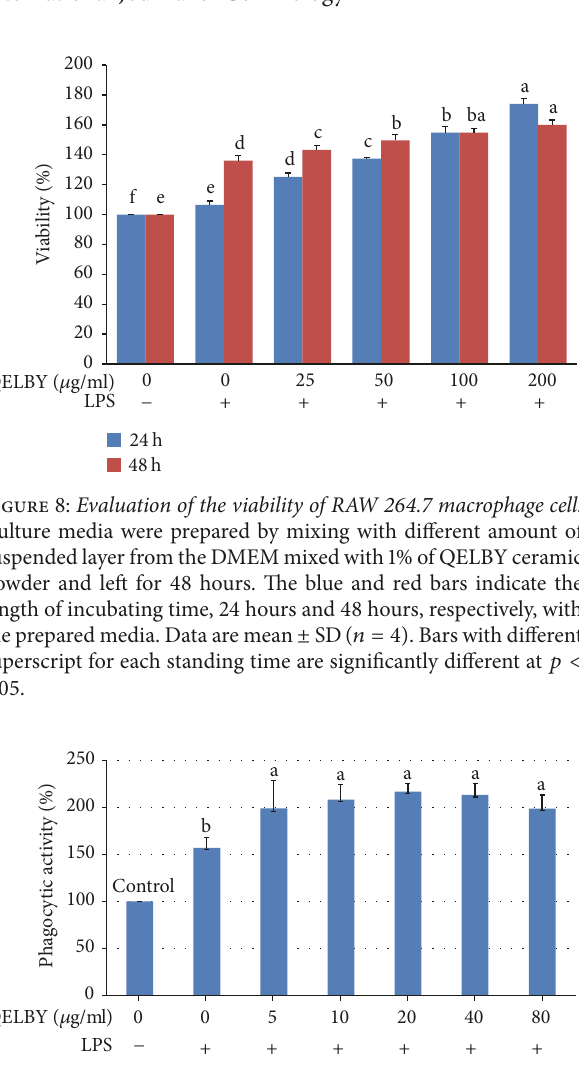
Figure 9: Evaluation of phagocytic activity. Phagocytic activity was measured by the uptake of neutral red dye. Culture media were prepared by mixing different amounts of suspended layers from the DMEM mixed with 1% of QELBY powder and left for 48 hours. Data are mean ± SD (𝑛 = 5) . Bars with different superscript are significantly different at 𝑝 < 0.05 .